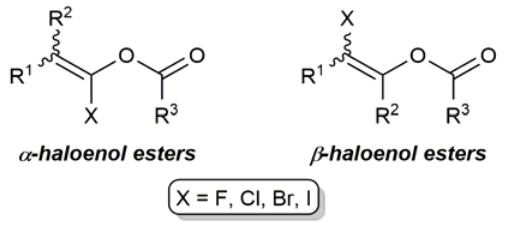
Figure 1. Generic structures of α - and β -haloenol esters.